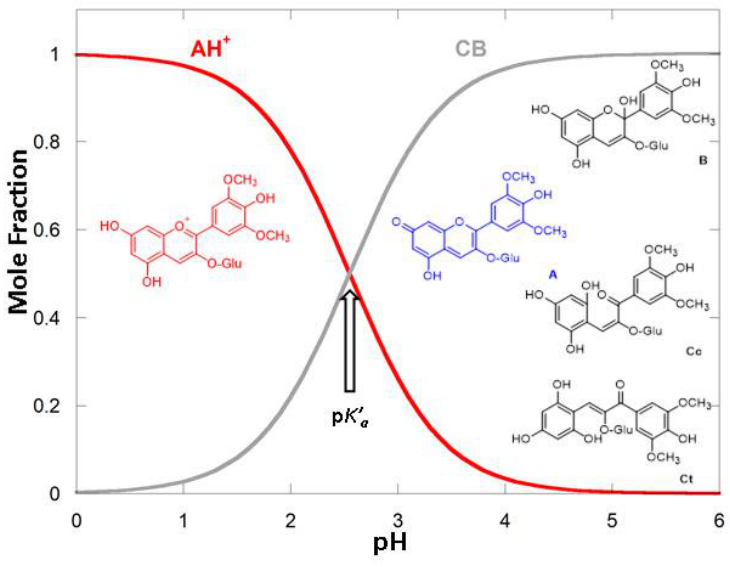
Figure 1. Oenin species distribution along the pH scale at the equilibrium, p K’ a = 2.8.